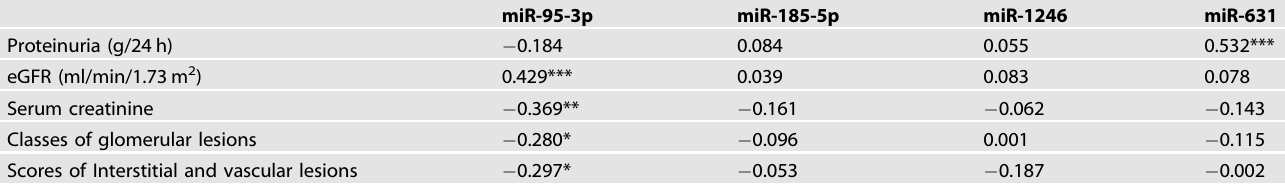
Fig. 3 The diagnostic accuracy of the diagnostic models was determined by ROC analysis in the validation cohort. a – d The ROC analysis is shown for Model DM, Model DN, Model IgAN, and Model MN in the validation cohort. DM diabetes mellitus, DN diabetic nephropathy, IgAN IgA nephropathy, MN membranous nephropathy. Table 3. Pearson correlations of relative microRNA expression levels and clinical parameters related to the severity of diabetic nephropathy.